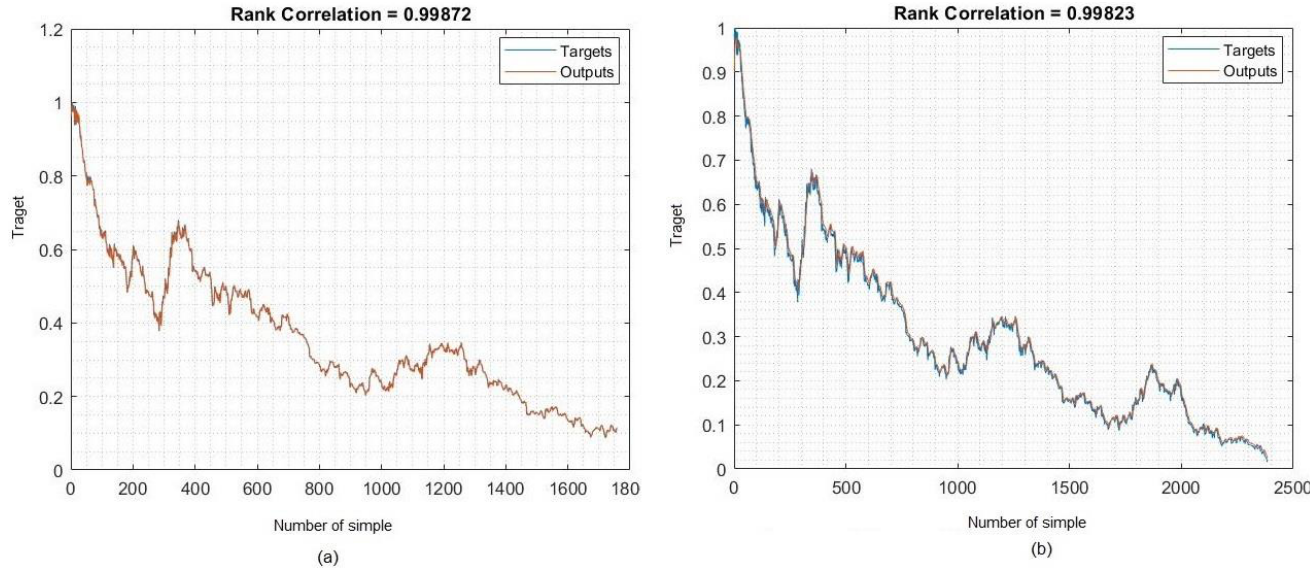
Figure 10. Rank correlation of deep learning models ( a ) CNN-LSTM and ( b ) LSTM for predicting the Apple stock market closing price during the training phase.